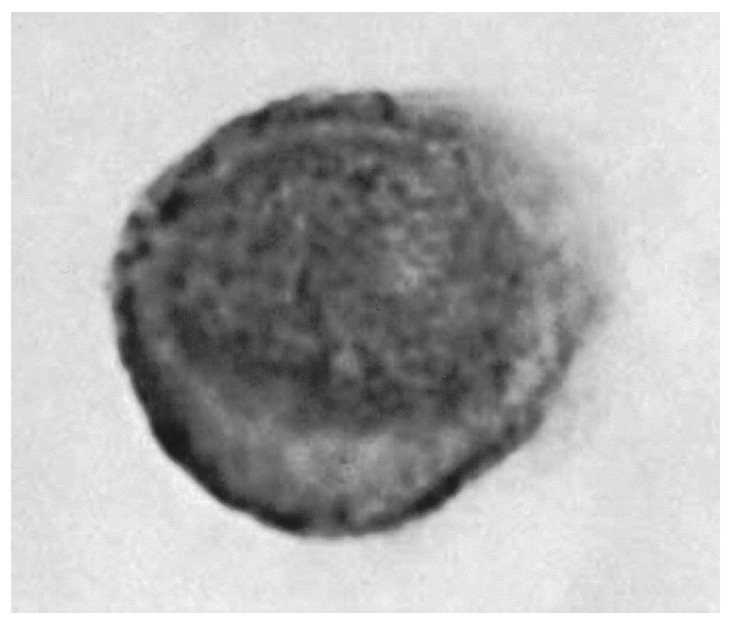
Immunocytochemical staining for siayl-LewisA antigen (sLeA) in the Capan-1 pancreatic cancer cell line. SLeA antigen was expressed on the cell surface of Capan-1 cells.